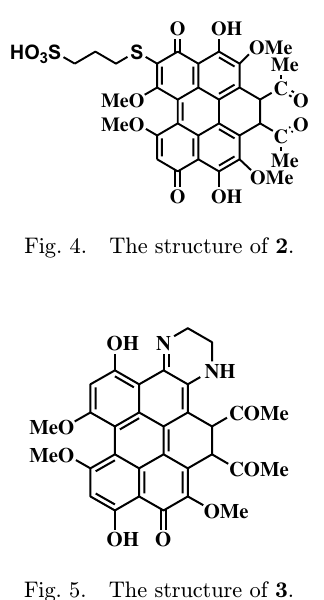
Fig. 5. The structure of 3